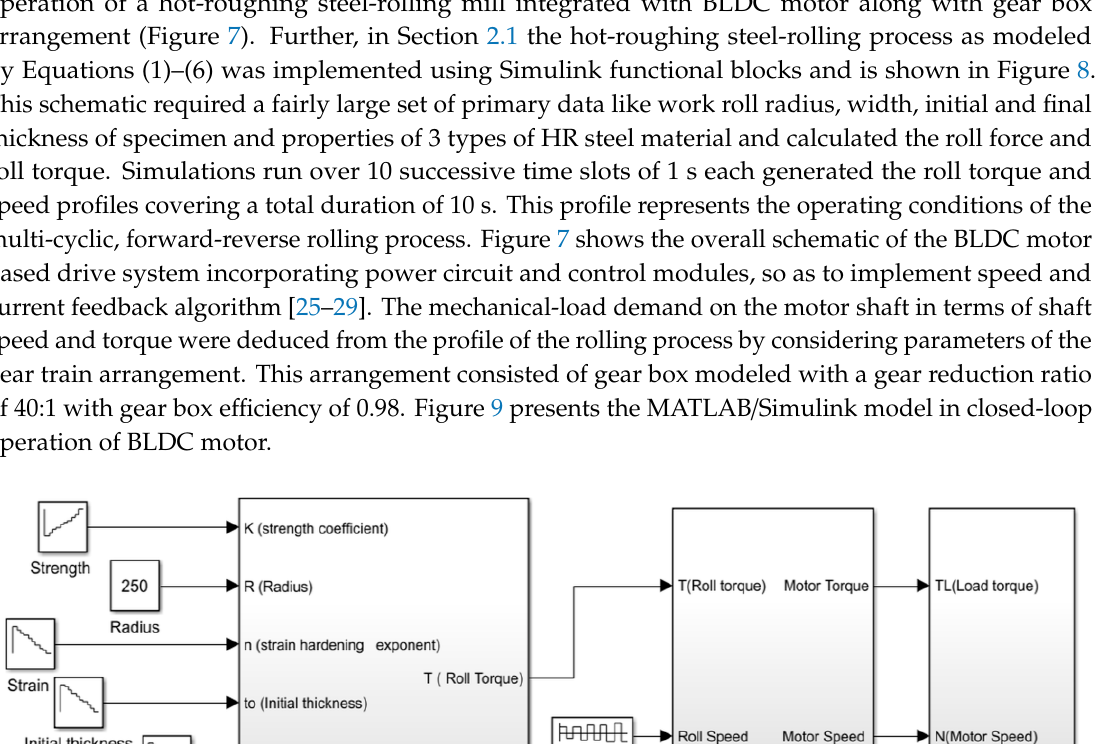
Figure 8. MATLAB/Simulink model of steel rolling process.